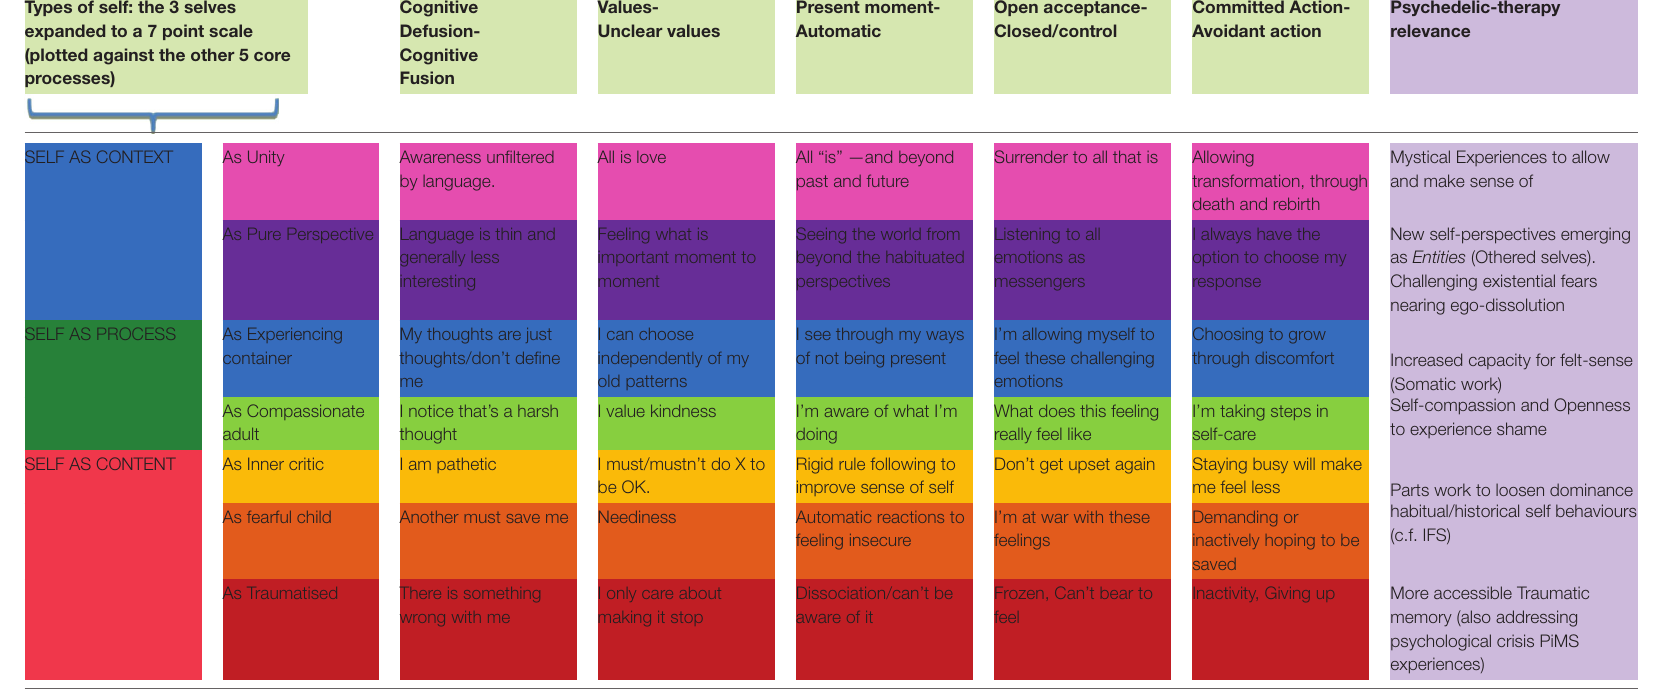
TABLE 2 | Non-self processes of psychological flexibility integrated as elements of different self-perspectives, and related to psychedelic phenomena. Types of self: the 3 selves expanded to a 7 point scale (plotted against the other 5 core